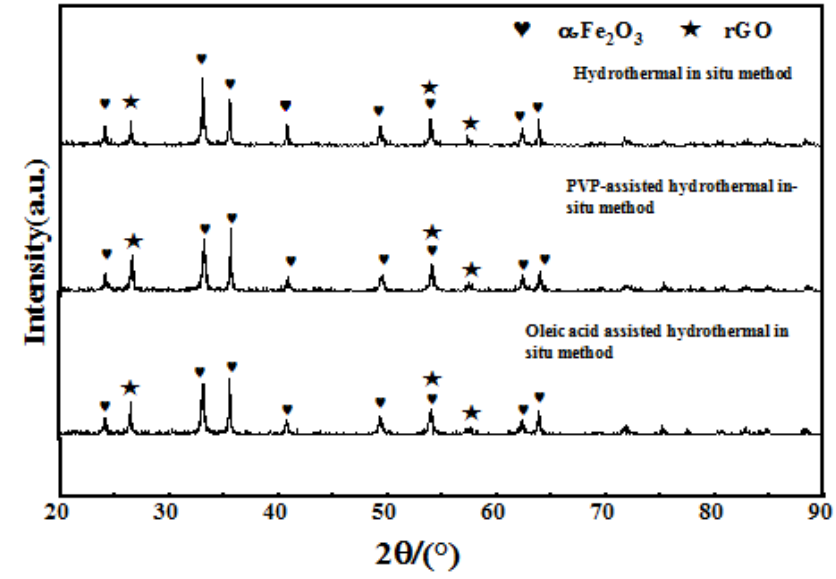
Figure 4: XRD pattern of Fe 2 O 3 /rGO composites prepared by three hydrothermal